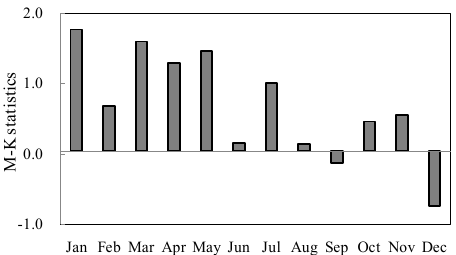
Fig. 6 M-K statistics of MP during 1961-2010 in the Jinsha River